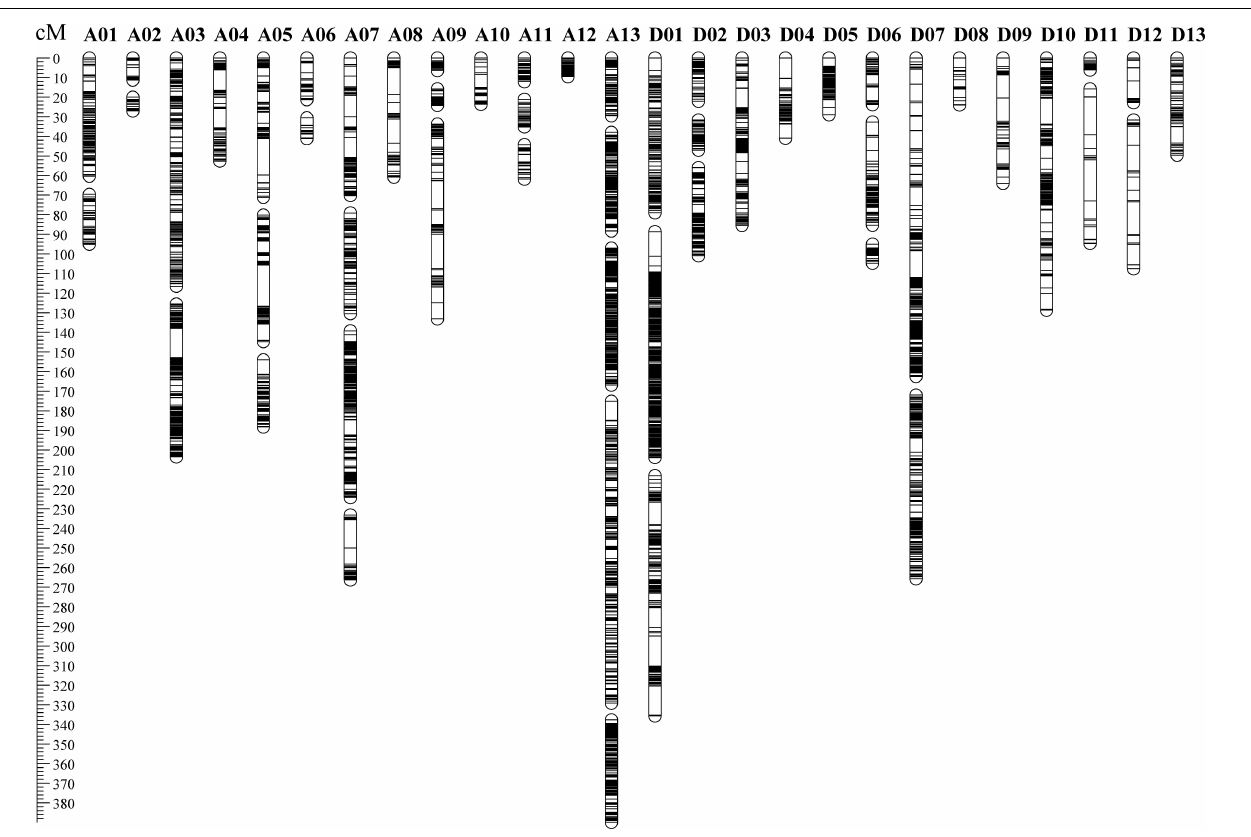
FIGURE 1 | The distribution of polymorphic markers in the genetic map constructed by the recombinant inbred line population.